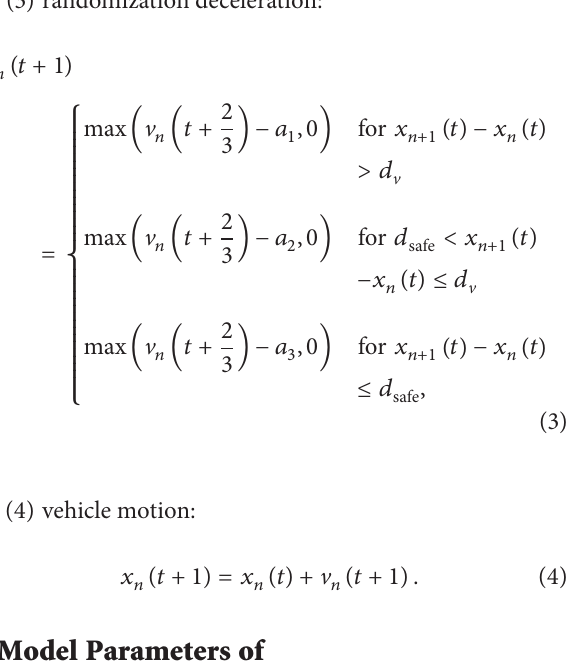
Table 1: Traffic capacity with the corresponding values of 𝜌